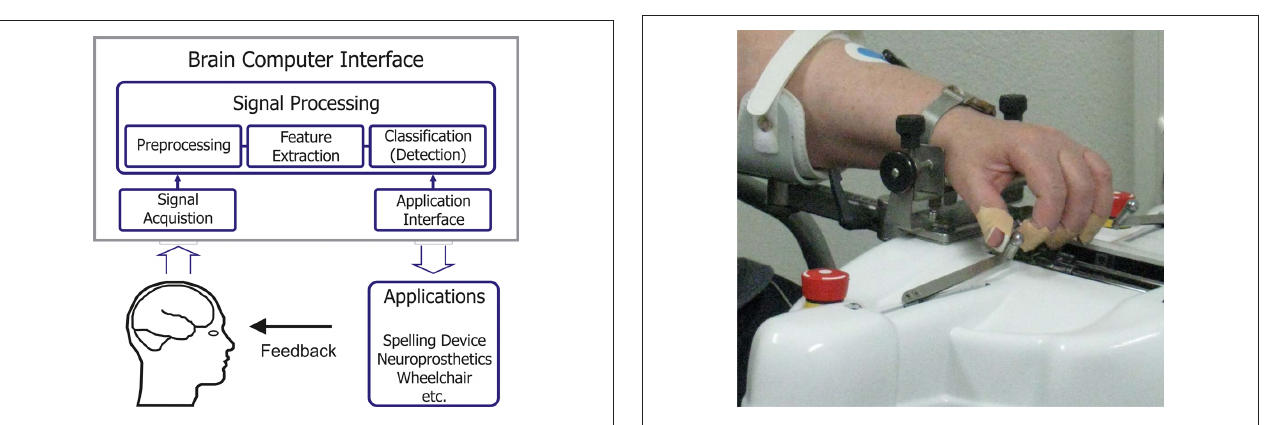
Figure 1 | Schema of a Brain–Computer interface. Figure 2 | Finger rehabilitation device